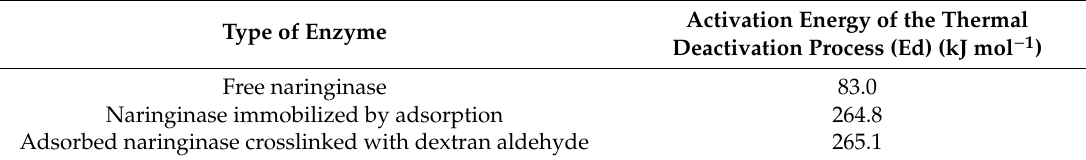
Table 5. Summary of the activation energy of the thermal deactivation process of free naringinase, naringinase immobilized by adsorption and naringinase crosslinked with dextran aldehyde.